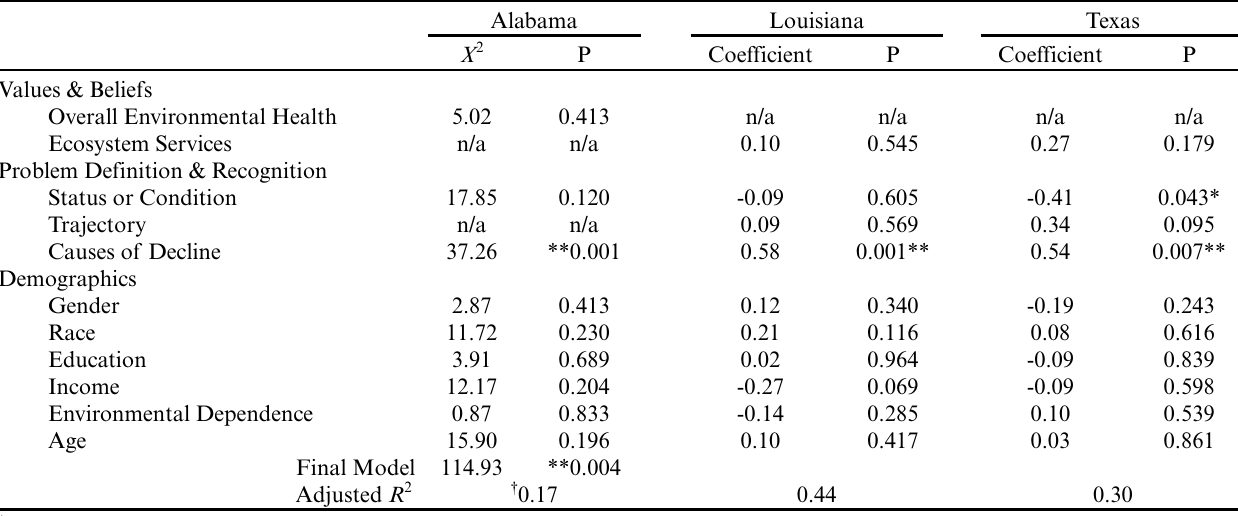
Table 5 . Final regression models for examining stewardship support in each state. For Alabama, multinomial logistic regression was used on the categorical response variable regarding the perceived most effective initiative. For Louisiana and Texas, linear regression models were used on the overall initiative support scale.